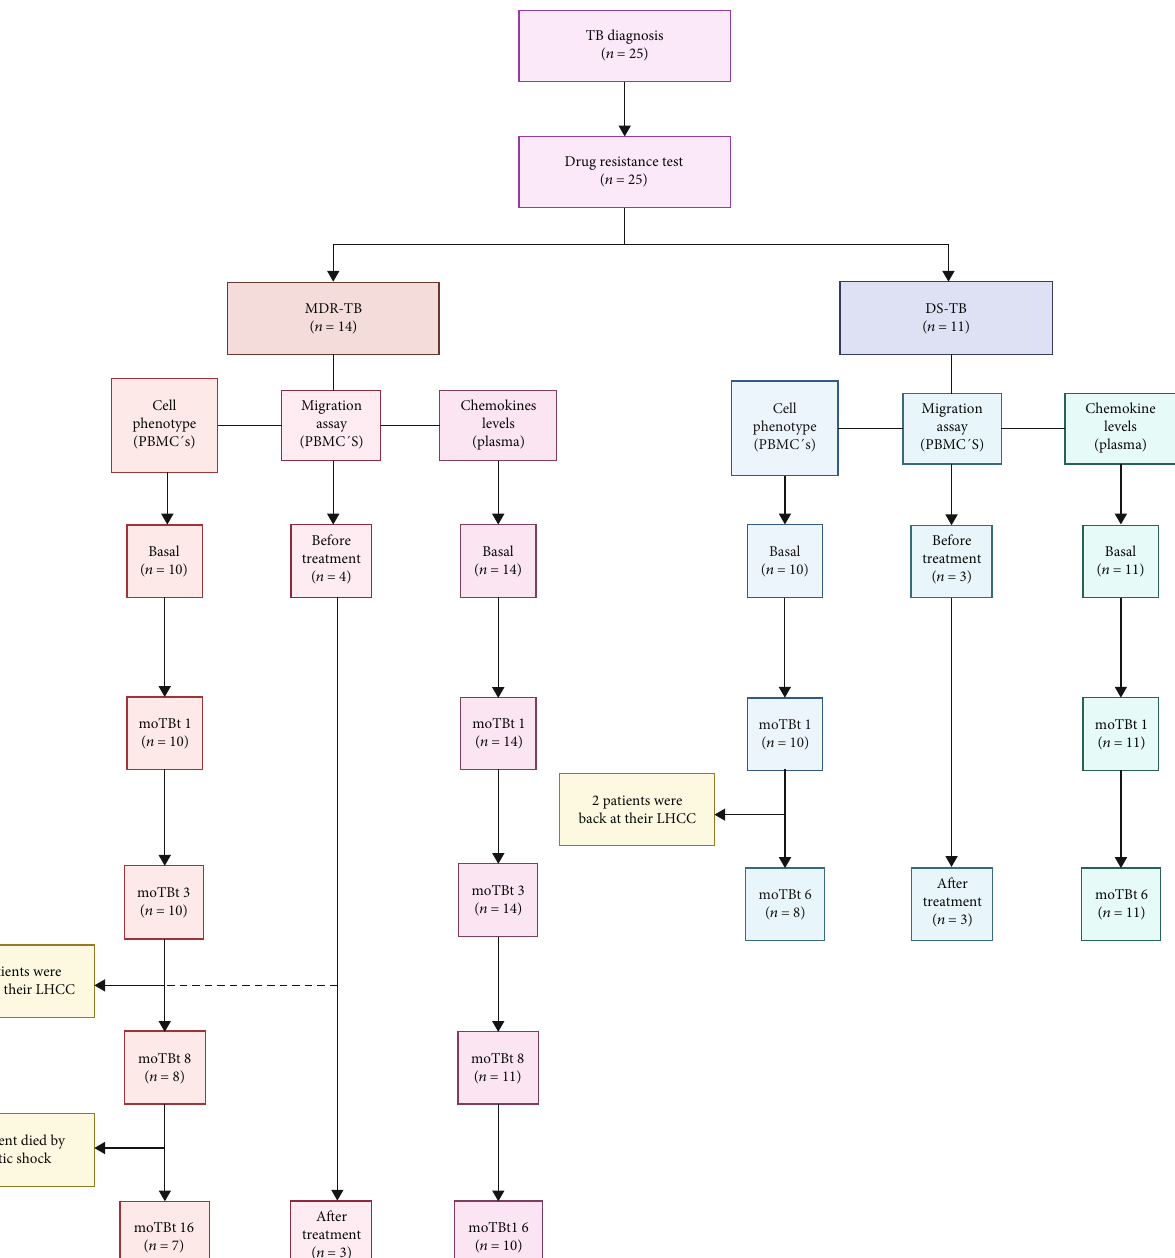
Figure 1: Work fl ow of DS-TB and MDR-TB patient recruitment and follow-up. A total of 25 TB patients were enrolled, 14 with multidrug- resistant (MDR-TB) and 11 with drug-sensitive (DS-TB). The fi rst group was maintained at baseline, 1 month, and 3 months of anti-TB therapy (moTBt). Then, three patients were sent back to their local health care center (LHCC), and the number of patients decreased to 11 at 8 moTBt. Furthermore, one patient died of septic shock. Thus the MDR-TB cohort at 16 moTBt included 10 patients (left). The cohort of DS-TB patients was also maintained from baseline to 1 moTBt, but at 3 moTBt, two patients were sent back to their LHCC. Thus, the DS-TB cohort at 6 moTBt included 9 patients (right). Cells from two DS-TB patients were used to cell phenotype and migration assay because of the low number of cells